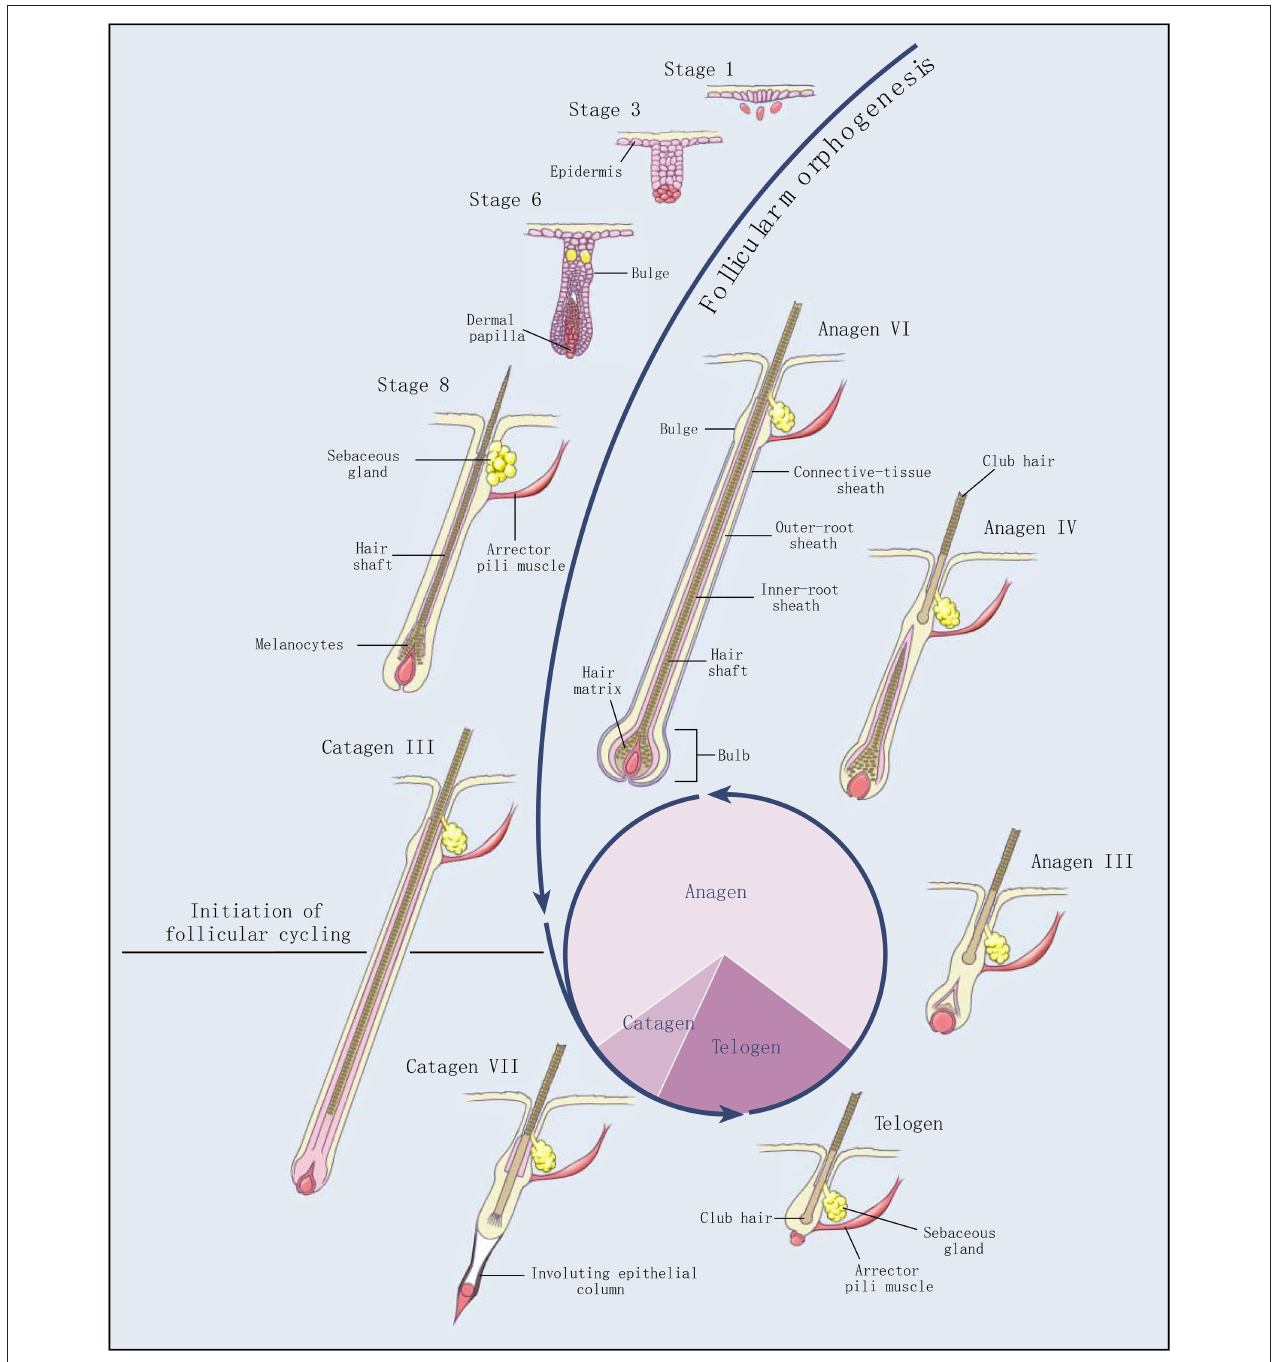
FIGURE 1 | Development and cycling of hair follicles (2). Selected stages of the morphogenesis of hair follicles and the three stages of follicular cycling (anagen, catagen, and telogen) are shown. The roman numerals indicate morphologic substages of anagen and catagen. The pie chart shows the proportion of time the hair follicle spends in each